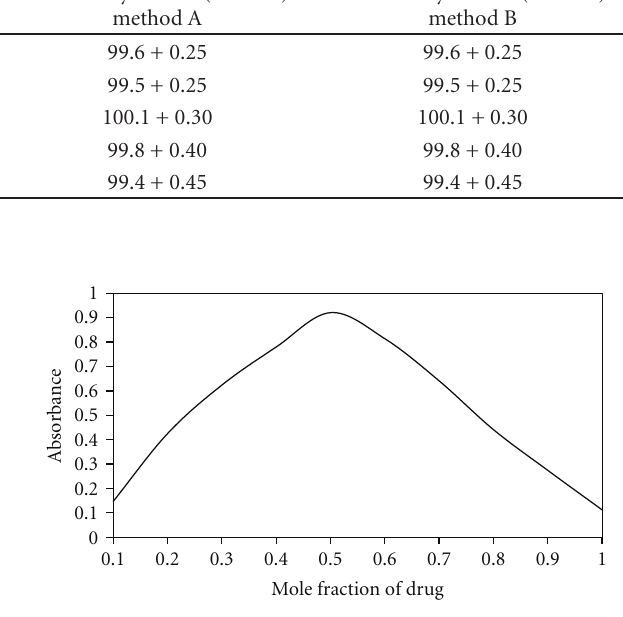
Figure 1: Absorbance spectra of the colored products produced from the reaction of alendronate sodium (5 μ g mL − 1 ) with DDQ ( ··· ) and TCNQ (—).